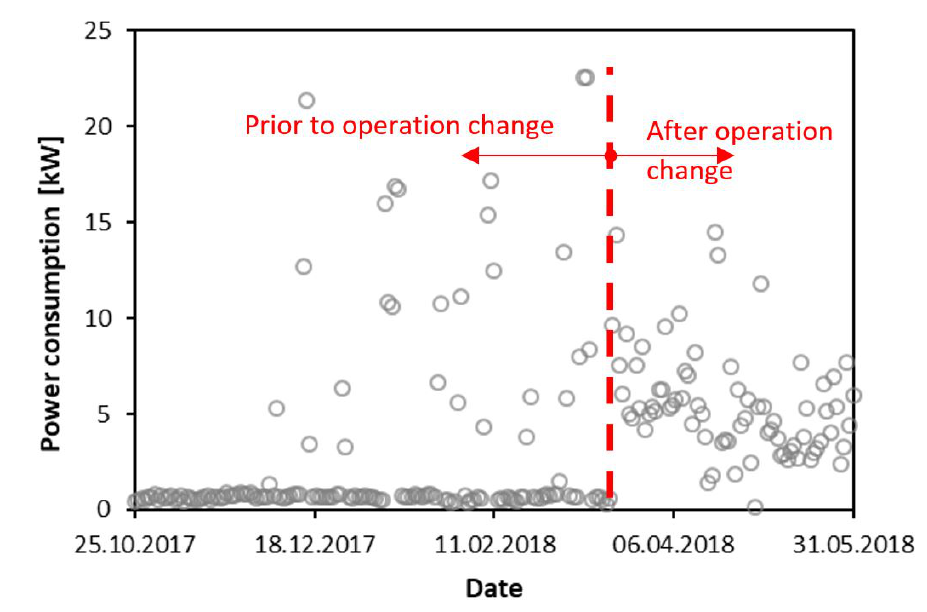
Figure 8. Thermal load for the pool circuit, plotted against the timeline, in averaged 1-day time step